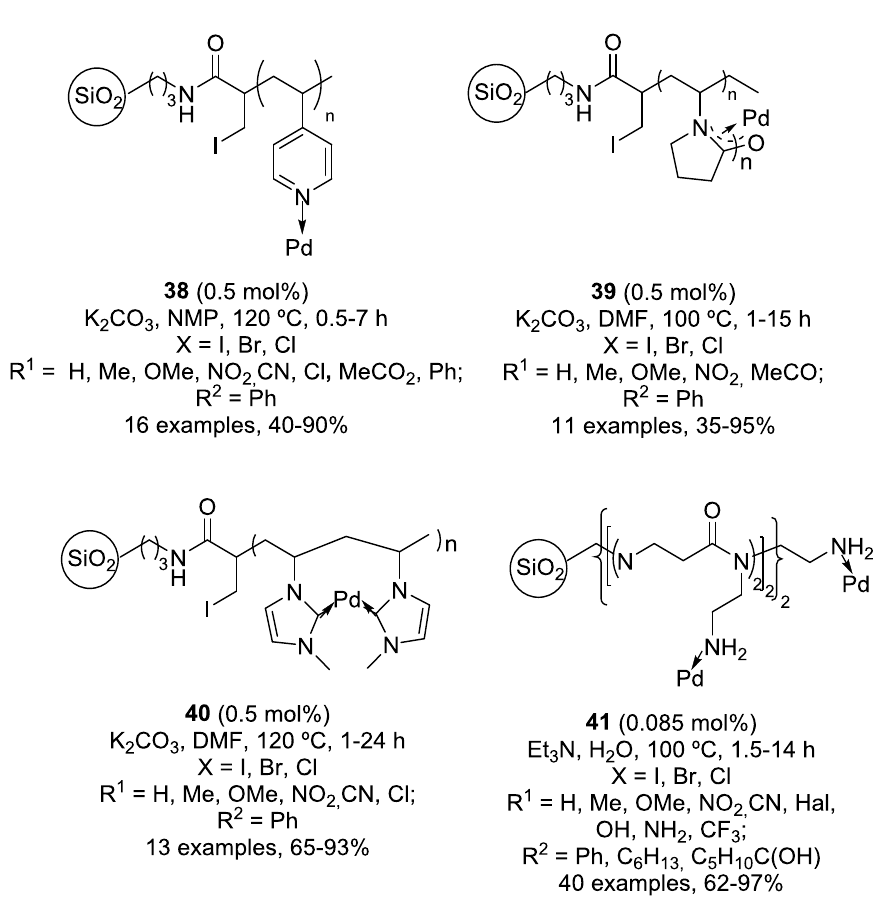
Figure 14. Immobilized PdNPs on polymer-grafted silica as catalysts in the Sonogashira cross-coupling reaction. Conditions, substrate scope and yield range (Scheme 2).